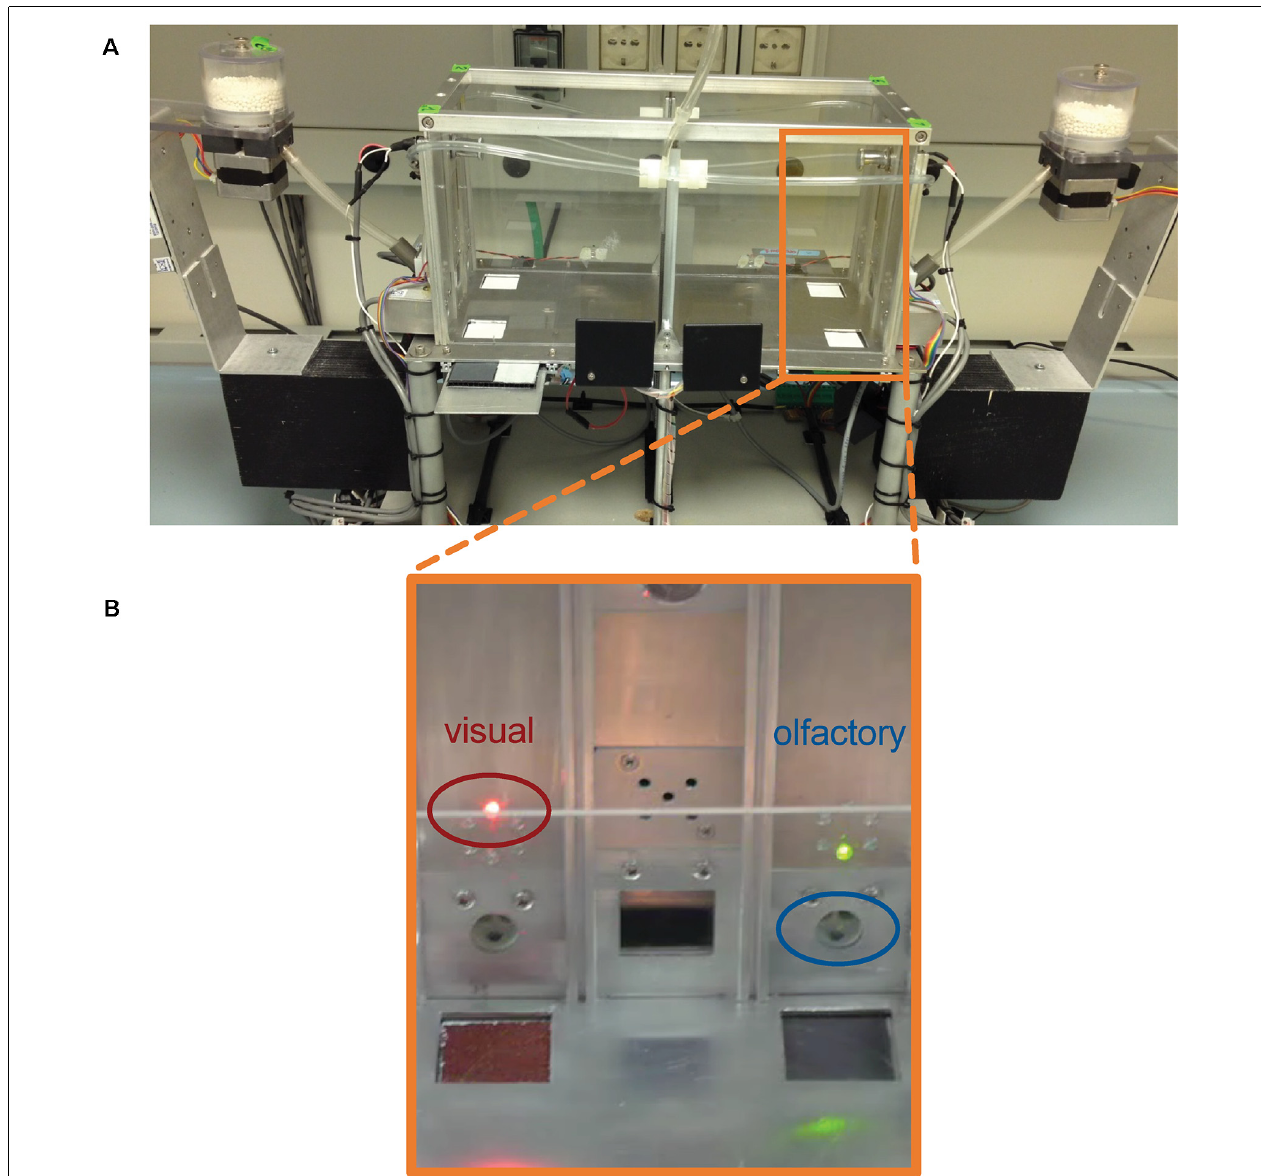
FIGURE 1 | (A) Photo of the two-chamber “ Operon ” apparatus. (B) Close up of the wall containing visual and olfactory stimuli. Light stimuli are located on the top of each nose poke hole. Light stimuli were switched on in pairs (red-green, yellow-blue, white-orange). Olfactory stimuli were presented inside the nose poke holes. All stimuli were counterbalanced between left and right nose poke